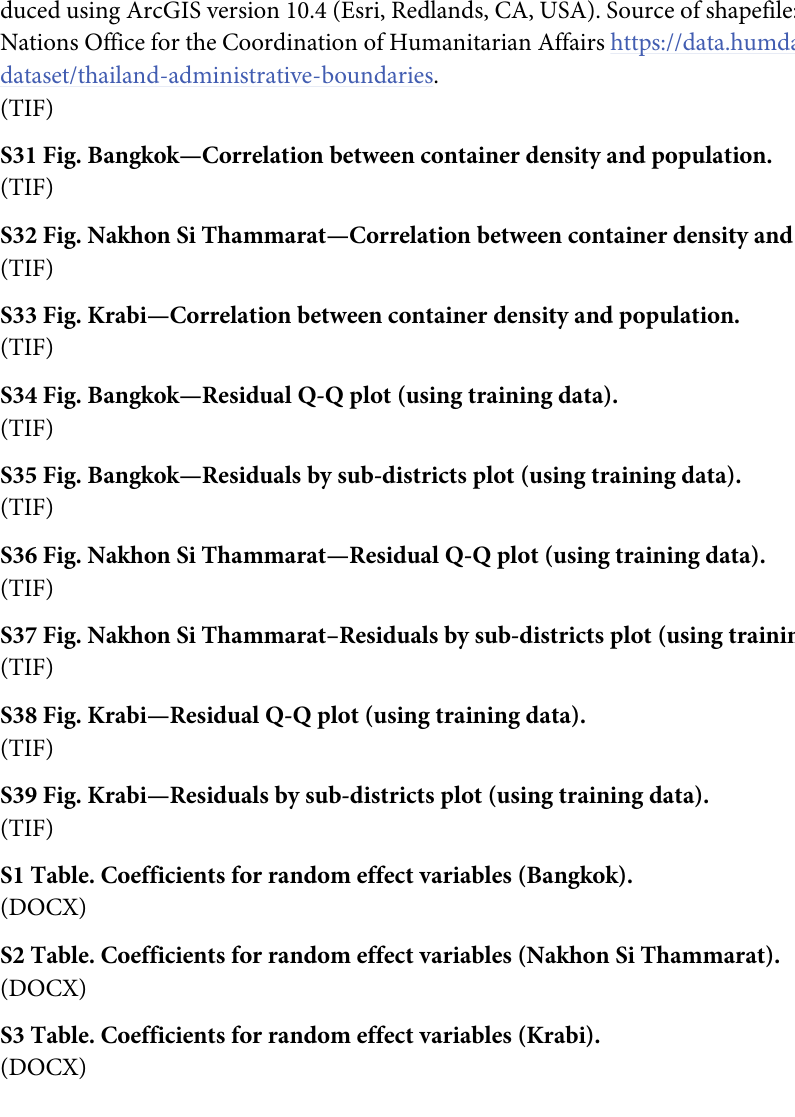
S31 Fig. Bangkok—Correlation between container density and population. S32 Fig. Nakhon Si Thammarat—Correlation between container density and population. (TIF) S33 Fig. Krabi—Correlation between container density and population. (TIF) S34 Fig. Bangkok—Residual Q-Q plot (using training data). (TIF) S35 Fig. Bangkok—Residuals by sub-districts plot (using training data). (TIF) S36 Fig. Nakhon Si Thammarat—Residual Q-Q plot (using training data). (TIF) S37 Fig. Nakhon Si Thammarat–Residuals by sub-districts plot (using training data). (TIF) S38 Fig. Krabi—Residual Q-Q plot (using training data). (TIF) S39 Fig. Krabi—Residuals by sub-districts plot (using training data). (TIF) S1 Table. Coefficients for random effect variables (Bangkok). S2 Table. Coefficients for random effect variables (Nakhon Si Thammarat). S3 Table. Coefficients for random effect variables